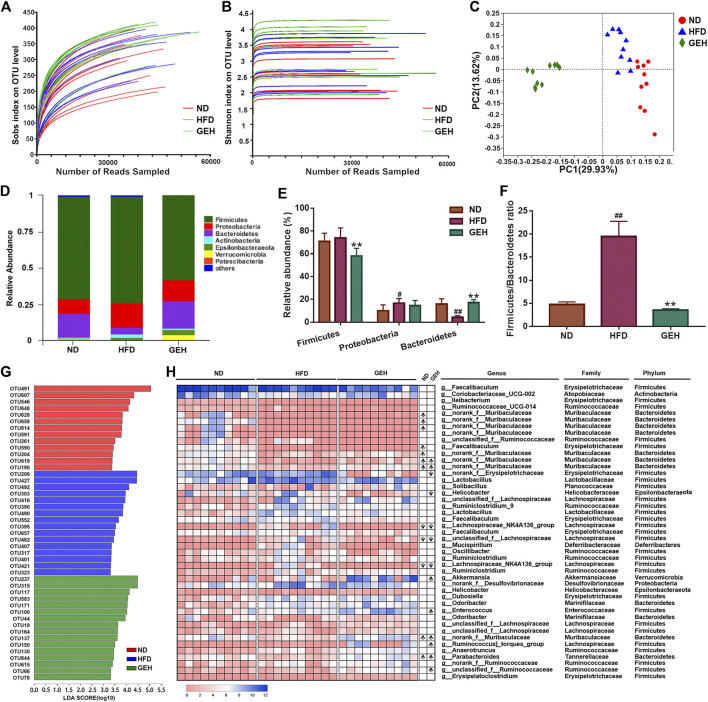
Effects of different treatments on the gut microbial composition. (A) Rarefaction curve. (B) Shannon curve. (C) Unweighted UniFrac-based PCoA plot of the mouse fecal bacterial community. (D) Bacterial phylum-level taxonomic profiling. (E–F) Relative abundance of dominant phyla and Firmicutes/Bacteroidetes ratio. (G) LDA score bar chart generated from the LEfSe analysis (LDA score >3). (H) Heatmap showing the abundances of 45 OTUs in different groups based on the LDA. The arrows (“↑” and “↓”) in the boxes represent the relative abundances of OTUs in the ND and GEH groups compared with the HFD group, respectively. n = 10 per group. #
p <0.05 or ##
p <0.01 vs. the ND group. *p <0.05 or **p <0.01 vs. the HFD group.